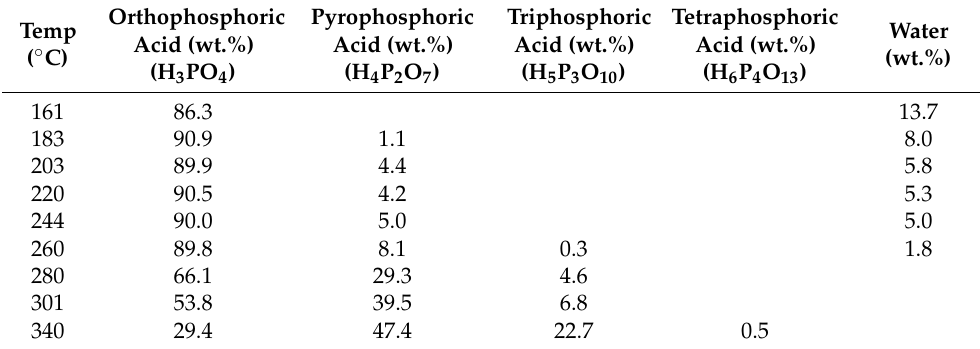
Table 1. Condensation of phosphoric acid with temperature